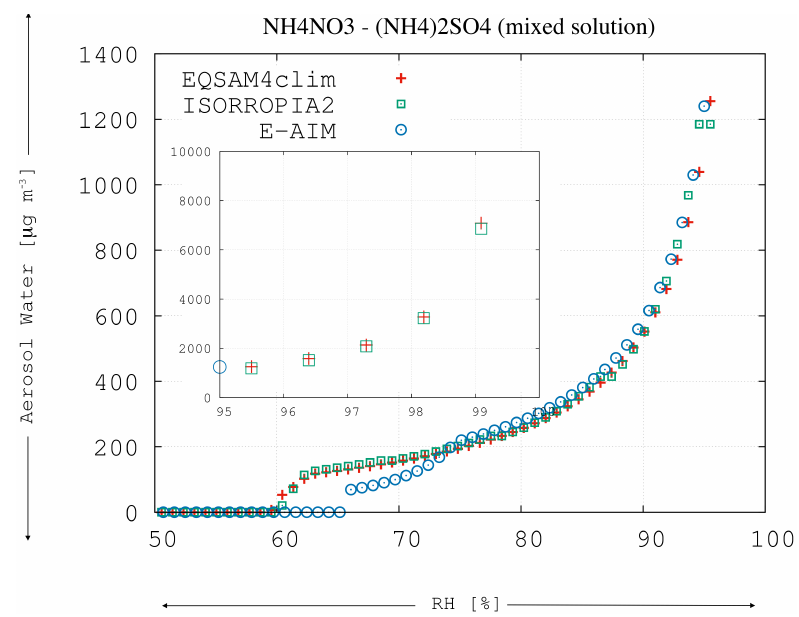
Figure 4. Results of EQSAM4clim (red crosses) and ISORROPIA II (green squares) for the total aerosol water mass m w,mix [ kgm − 3 ( air ) ] obtained by Eq. (22) for the mixed solution of NH 4 NO 3 and ( NH 4 ) 2 SO 4 shown in Fig. 3 (lower panels). The results are shown for RH = 50– 97 [ % ] (large panels) and for the RH = 95–99.5 [ % ] (small panel). The results of E-AIM (web version) (blue circles) are included for comparison. The mixed solution RHD has been obtained for EQSAM4clim from Eqs. (13)–(22) and are based on measured MDRH values for ISORROPIA II. The mutual deliquescence range of EQSAM4clim and ISORROPIA II (described in Sect. 2.6) differs from those of E-AIM (web version: http://www.aim.env.uea.ac.uk/aim/aim.php. This figure is extended by Fig.